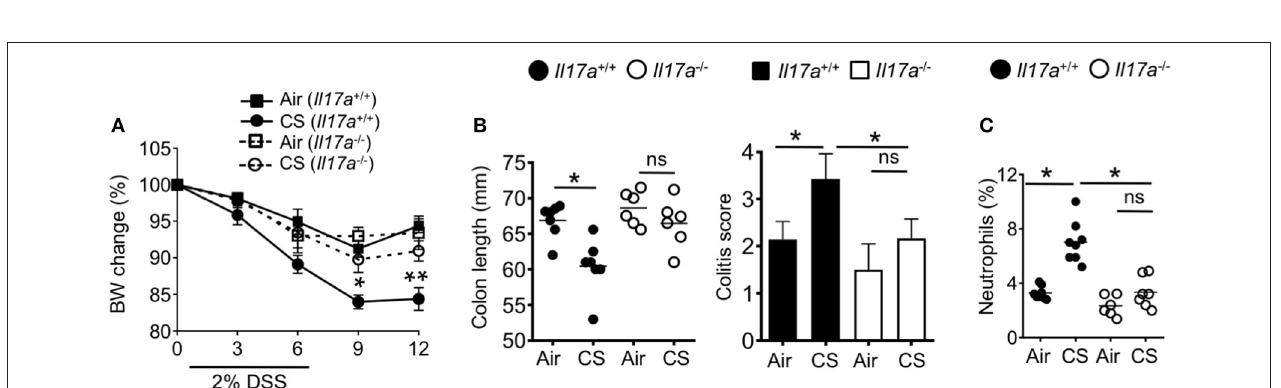
FIGURE 7 | Cigarette smoke-induced neutrophil recruitment and intestinal inflammation depends on IL-17A. (A) Body weight change (%) of indicated mice exposed to air or CS for 2 months followed by DSS treatment. (B) Colon length and colitis scores after 2% DSS treatment. (C) Frequencies of neutrophils (CD11b + Ly6G + cells) in the colon after DSS treatment were assessed by flow cytometry. Representative and pooled data obtained (mean ± SEM) from two independent experiments with 6–8 animals are shown. Kruskal-Wallis test with Dunn’s multiple comparison were used to test for significance. ns, P > 0.05; * P ≤ 0.05; ** P < 0.01.